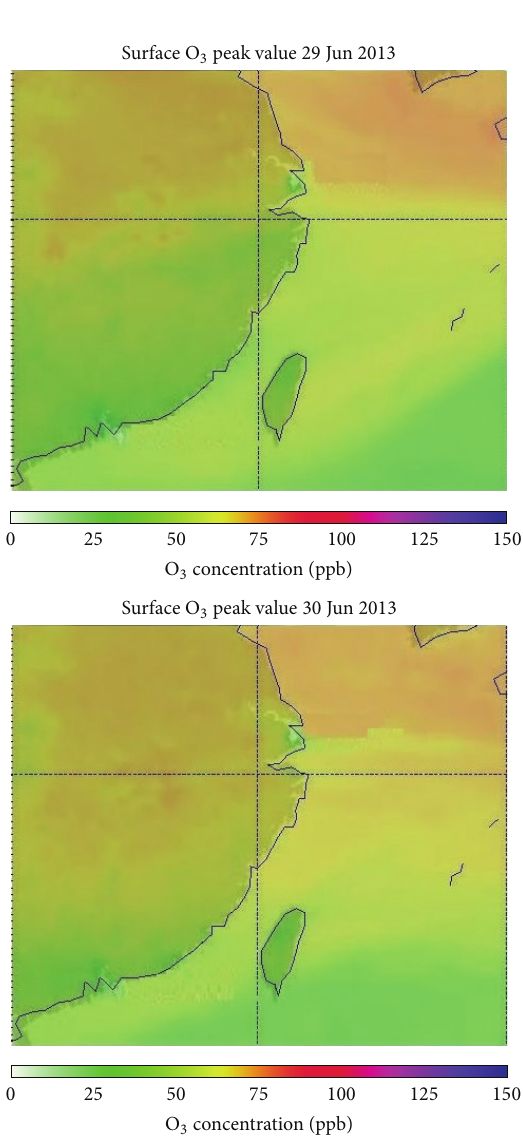
Figure 2: Monitor surface peak concentration of O 3 on June 29 and 30,